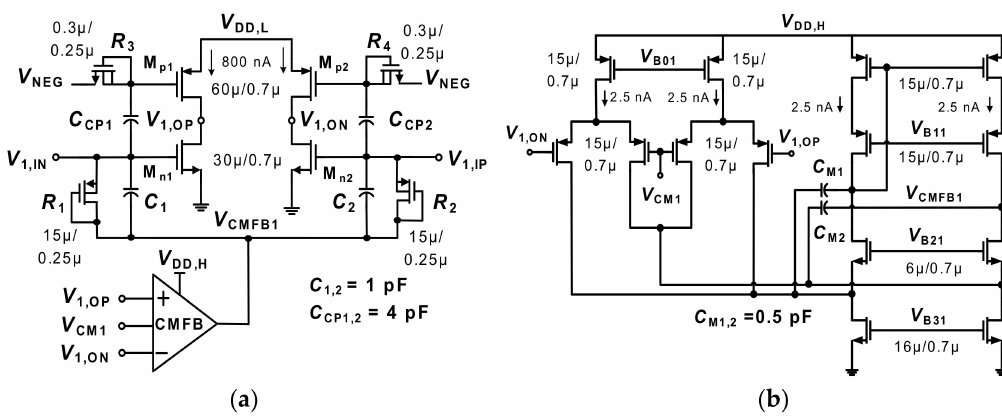
Figure 3. ( a ) Schematic of the squeezed-inverter stage using the shared common-mode feedback (CMFB). V CM1 = 0.1 V, V NEG = − 0.18 V, and V CMFB1 = 0.098 V (nominal value). ( b ) Schematic of the proposed CMFB circuit. V B01 = 0.57 V, V B11 = 0.28 V, V B21 = 0.49 V, and V B31 = 0.23